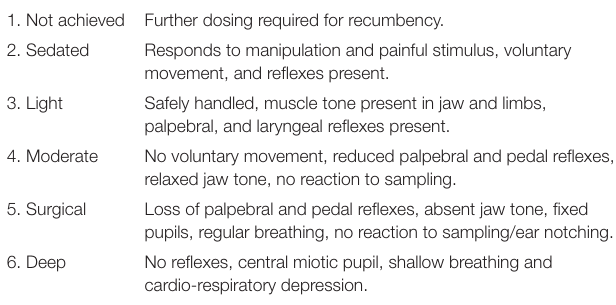
TABLE 1 | Immobilization scoring system for warthogs. 1. Not achieved Further dosing required for